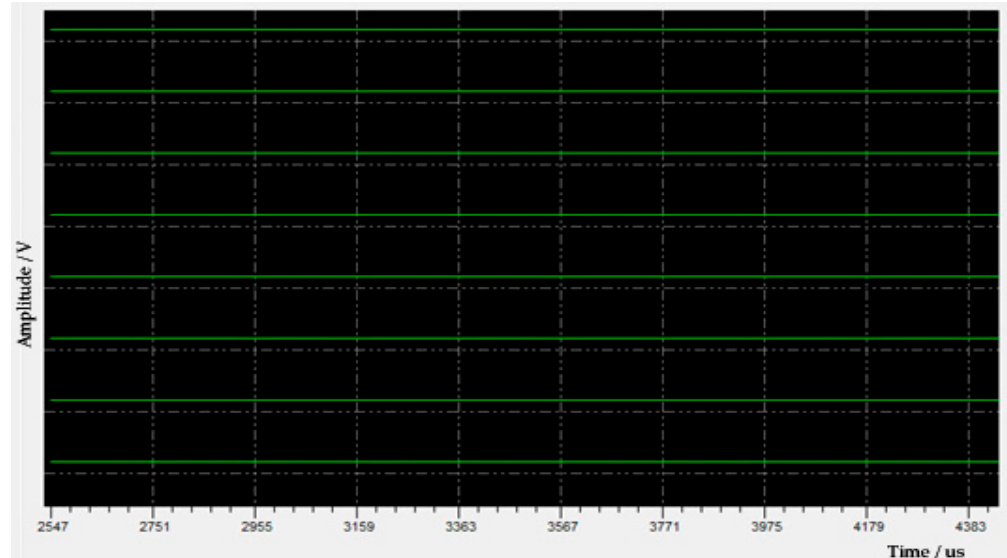
Figure 11. Abnormal environmental noise data uploaded by the tool.